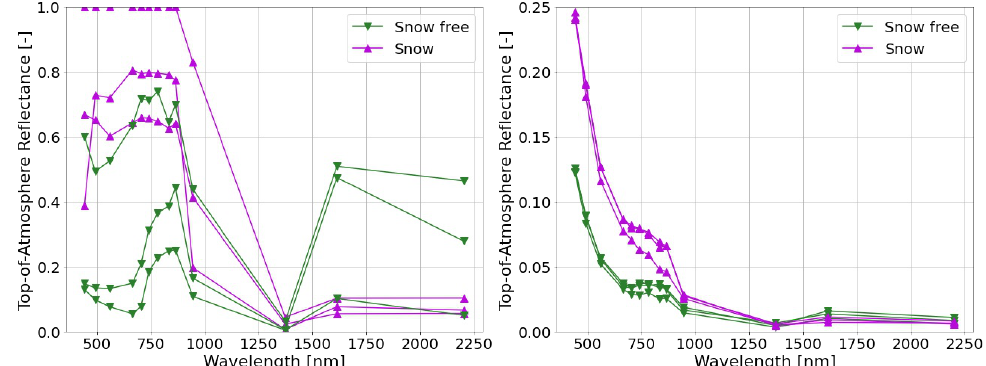
Figure 2. Both figures show three green curves for the snow-free spectral signatures and three purple curves for the snow-covered spectral signatures. The values are the Sentinel-2B MSI TOA reflectances from Figure 1. The ( left ) hand figure displays the reflectances for the well-illuminated spectra (round markers in Figure 1), and the ( right ) hand figure displays the reflectance for the shaded spectra (diamond markers in Figure 1). Please note the different scales on the y-axis.